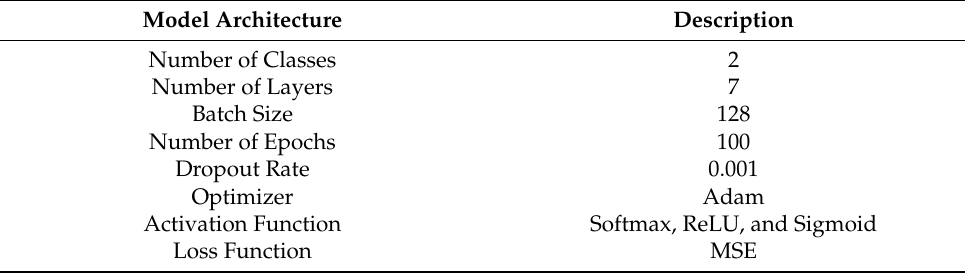
Figure 3. The LSTM-Autoencoder Model—a flowchart showing the steps from data acquisition to deployment. Table 1. LSTM-Autoencoder Architecture Model